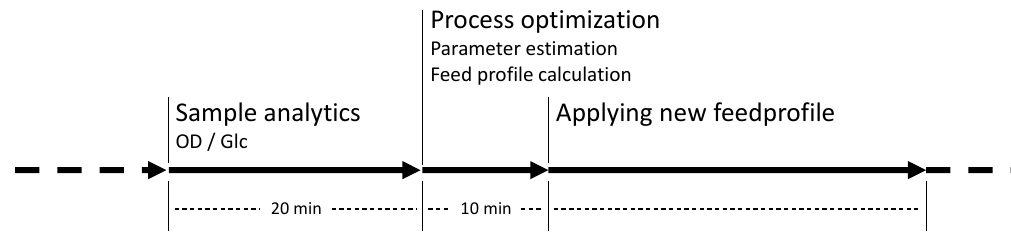
Figure 4. Schematic workflow to apply the NMPC control to a fed-batch process with a cycle time of one hour.